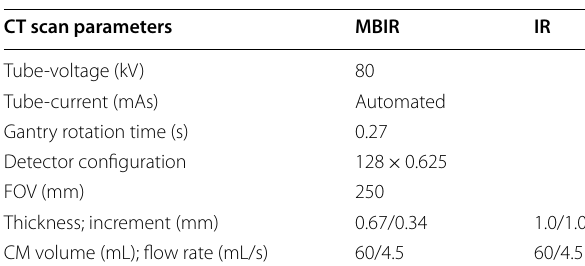
Table 1 Scanning parameters and reconstruction algorithms